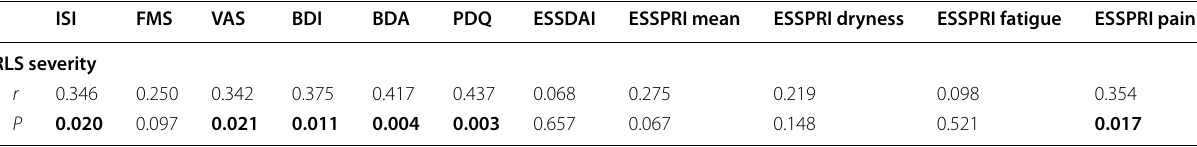
Table 3 Correlation between RLS and evaluation